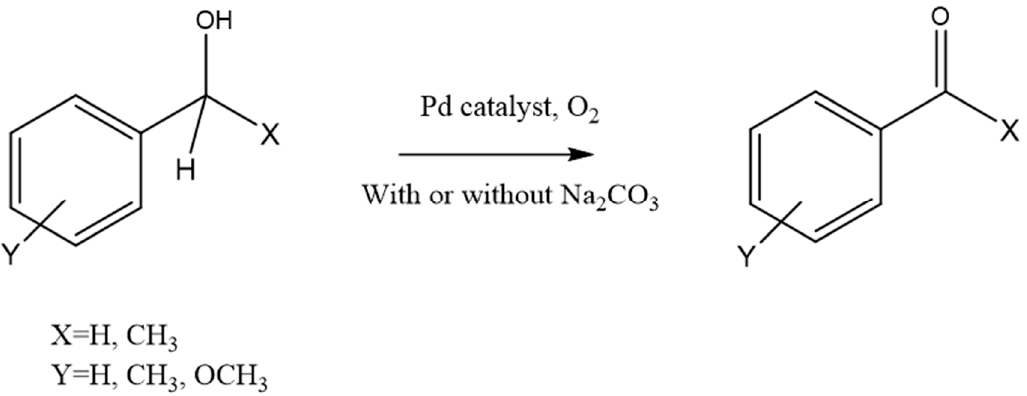
Figure 1. Aerobic oxidation of benzylic alcohols.